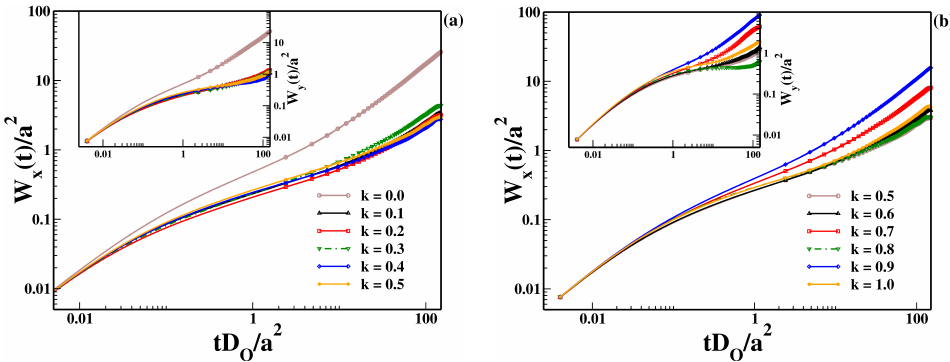
Figure 7. W x ( t ) for different values of the stiffness parameter, k , to cover low couplings. ( a ) 0 ≤ k ≤ 0.5, ( b ) 0.5 ≤ k ≤ 1.0. Inset shows the MSD in the y